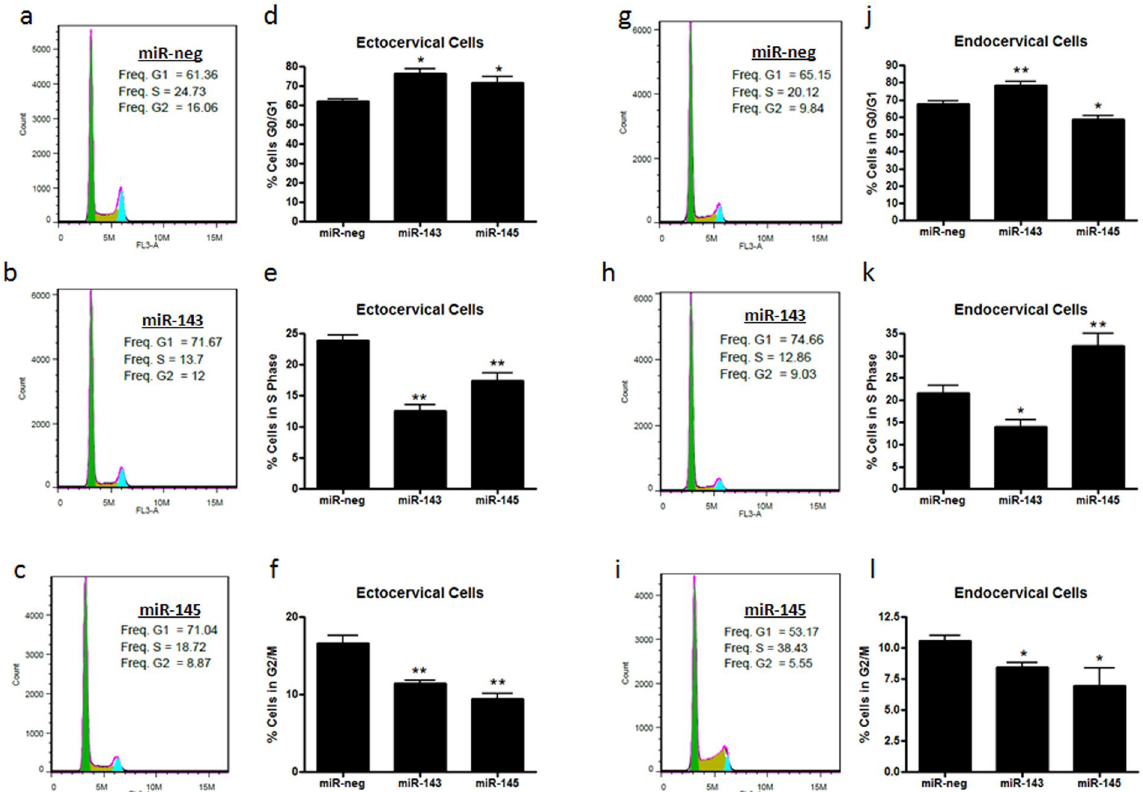
Figure 7. miR-143 and miR-145 overexpression results in cell cycle arrest. Ectocervical and endocervical cells transfected with miR-negative control (miR-neg), miR-143 or miR-145 were used for cell cycle assays by flow cytometry. Representative cell cycle histograms show the percentage of ectocervical and endocervical cells in each phase of the cell cycle after miR-neg ( a , g ), miR-143 ( b , h ) and miR-145 ( c , i ) transfection. Bar graphs show the average (n = 4 independent experiments) percentage of cells in each phase of the cell cycle. miR-143 and miR-145 over expression resulted in cell cycle arrest at G0/G1 ( d ) in ectocervical cells ( d , e , f ). In endocervical cells ( j , k , l ), similarly, miR-143 transfection caused cell cycle arrest at G0/G1 ( j ), while, miR-145 transfection resulted in S-phase arrest ( k ). Values are mean ± SEM * p < 0.05, ** p <